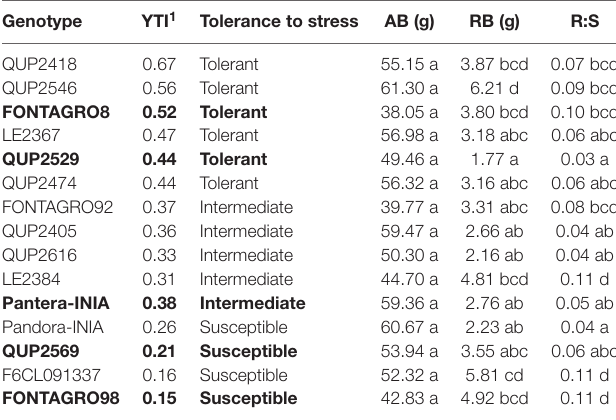
TABLE 1 | Set of wheat genotypes tolerant or susceptible to water stress according to the yield tolerance index (YTI), total aerial biomass (AB), total root biomass (RB), and root to shoot ratio (R:S) in